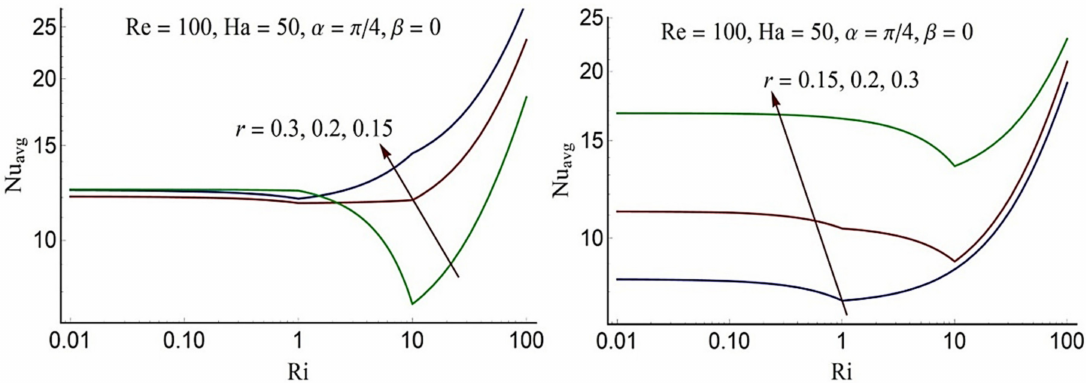
Figure 5. The average Nusselt number at different radii against Ri, ( Left ): At the surface of circular heater, ( Right ): At the top